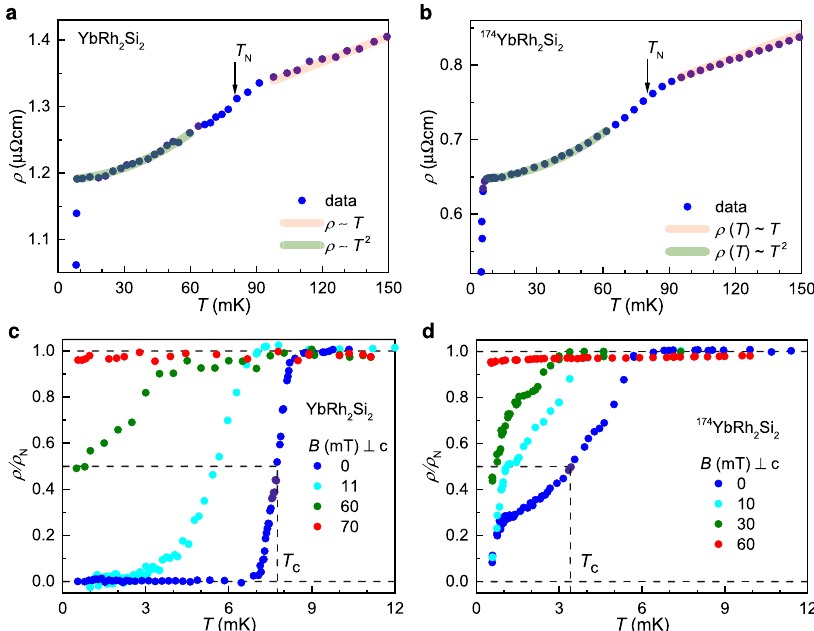
Fig. 1 Temperature dependence of the electrical resistivity of YbRh 2 Si 2 and 174 YbRh 2 Si 2 . a , b Electrical resistivity ρ ( T ) below 150 mK, showing linear-in- T behavior above the Neel temperature T T 2 behavior below it, and the onset of superconductivity at the lowest temperatures. c , d Electrical resistivity N , below 12 mK, scaled to its normal-state resistivity ρ N just above the transition, showing the superconducting transition at T c , which we de fi ne as the temperature where ρ ( T ) has dropped to ρ N /2. Magnetic fi elds (applied within the tetragonal a - a plane) successively suppress T c . The 10 and 30 mT curves for 174 YbRh 2 Si 2 were extracted from isothermal fi eld sweeps (Fig. 3b); all other curves were recorder as function of temperature. Table 1 Characteristics of the investigated YbRh 2 Si 2 and 174 YbRh 2 Si 2 single crystals. Sample